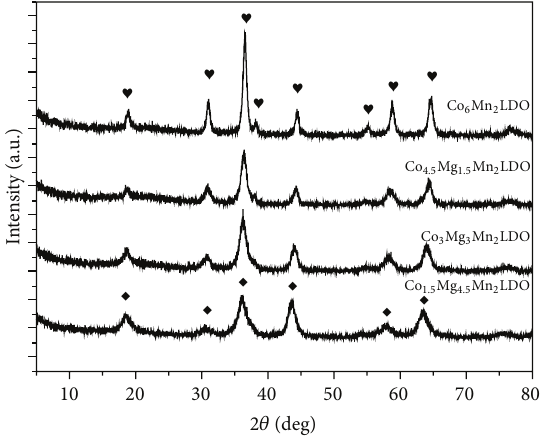
Figure 2: XRD patterns of the Co 𝑥 Mg 6−𝑥 Mn 2 LDO samples ( X : MnCo 2 O 4 phases; P : Co 3 O 4 ).